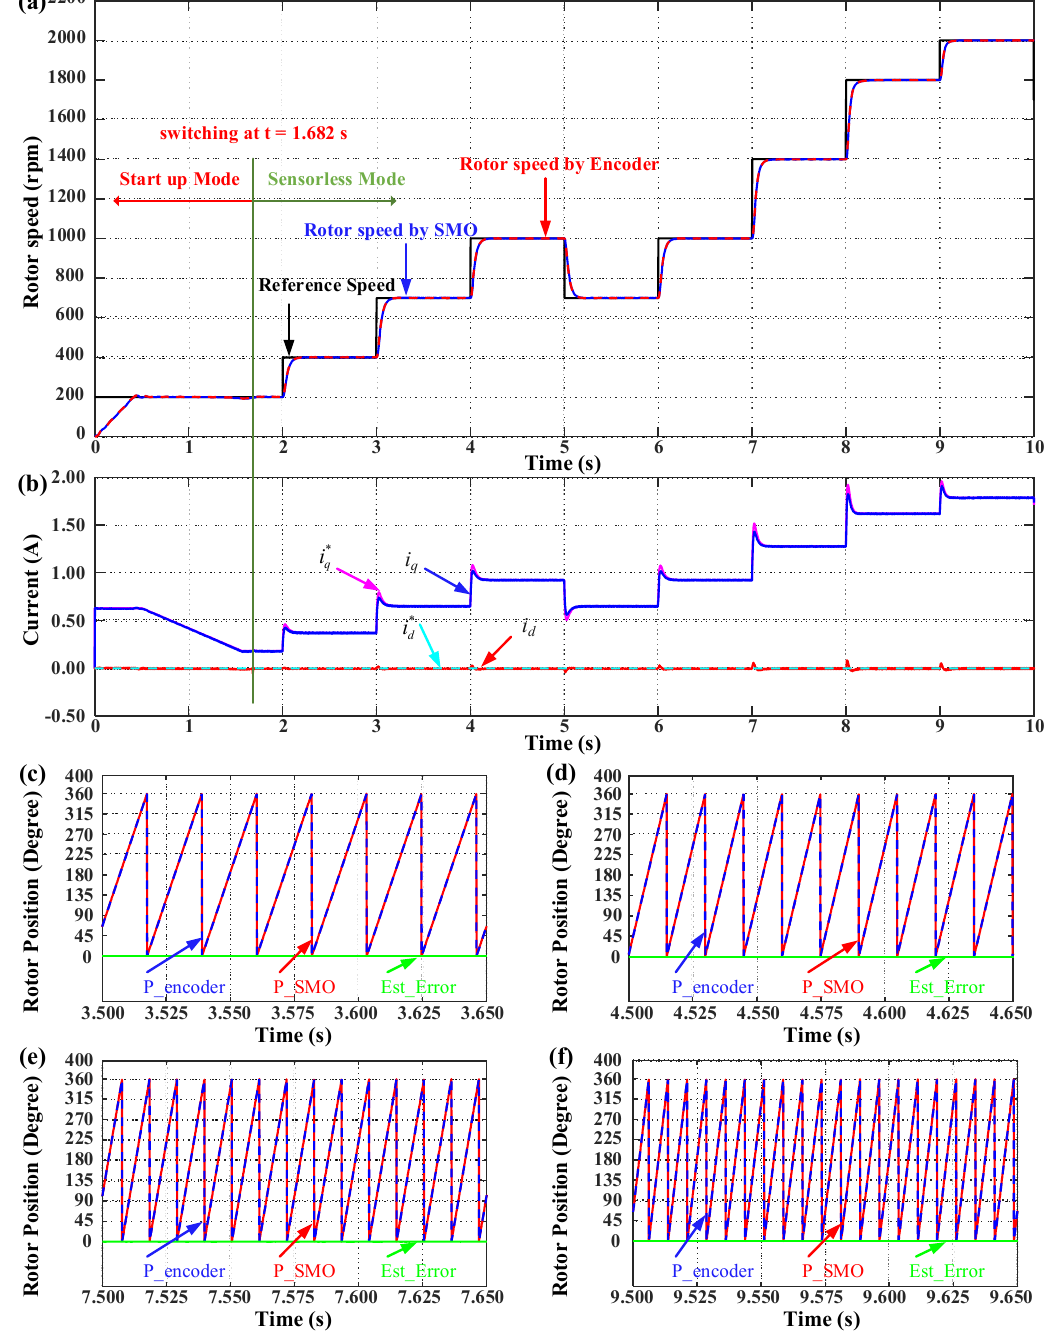
Figure 8. Simulation results in the speed increasing strategy, from 0 to 2000 rpm, for ( a ) speed response, ( b ) current response, and rotor position response at ( c ) 700, ( d ) 1000, ( e ) 1400, ( f ) 2000 rpm.